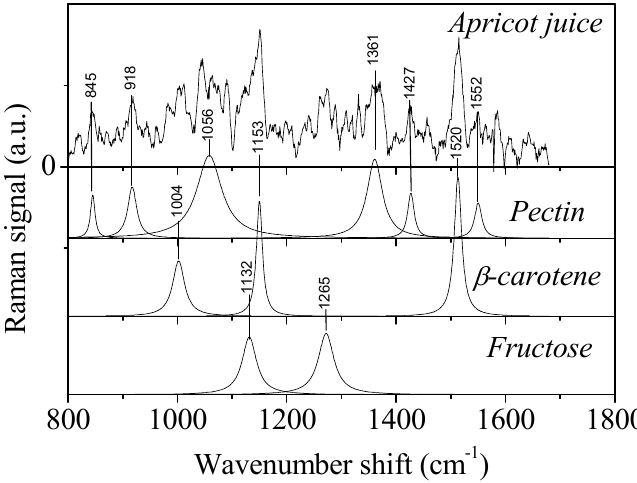
Figure 5 . Results of deconvolution procedure on Raman spectrum of apricot juice (Sample C) before depectinization process and comparison with pectin, β -carotene and fructose spectra. Table 3 . Tentative assignment of the main peaks in Raman spectrum of apricot fruit juice in the